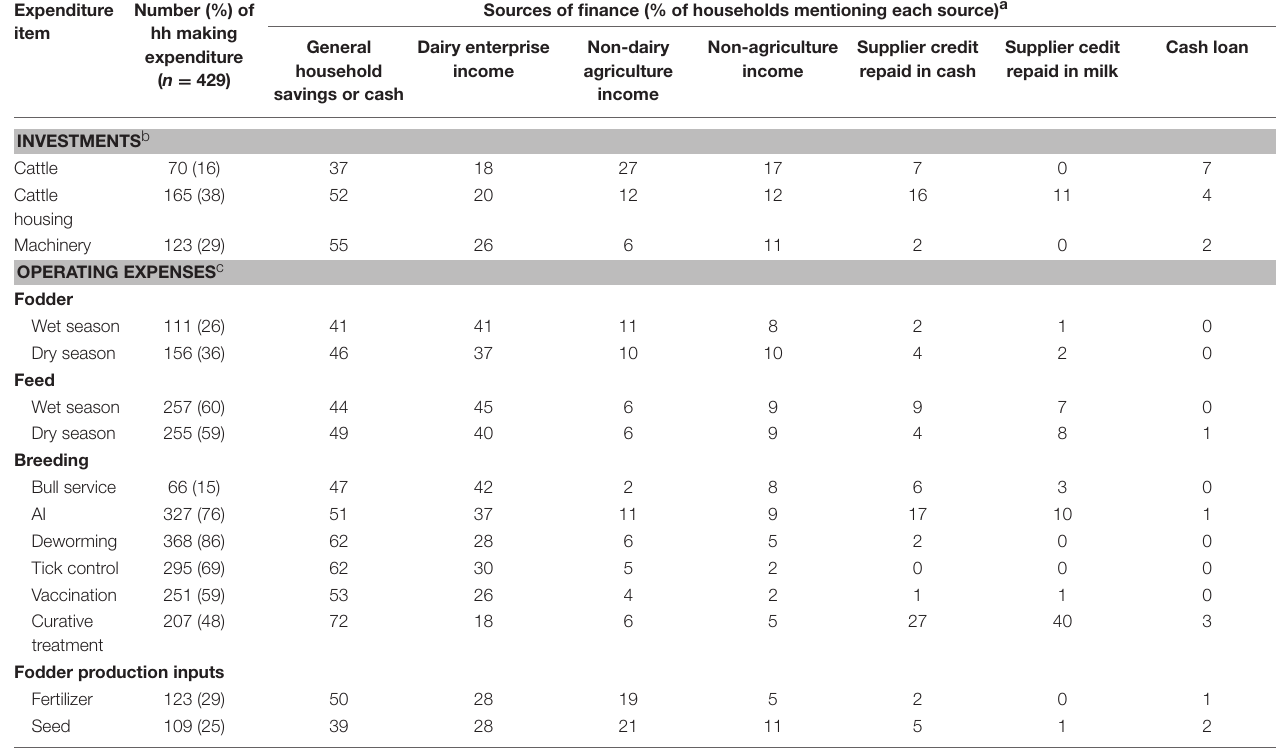
TABLE 2 | Sources of finance for household dairy enterprise investment and operating costs. Expenditure